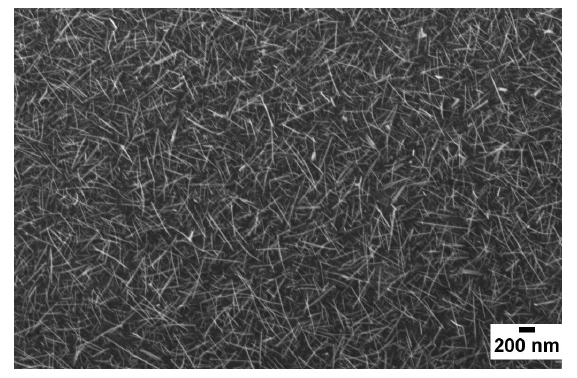
Figure 5: SEM picture of WO 3 nanowires on alumina